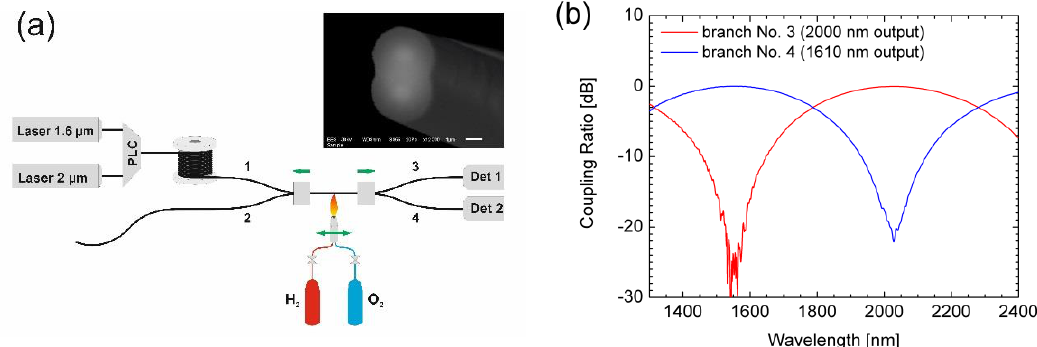
Figure 5. ( a ) Setup of the tapering rig for producing fiber components by the fused-biconically-tapered fabrication method. PLC: Planar lightwave circuit; Det: detector. Inset: scanning-electron-microscope image of the cross section near the waist position of the tapered region (the waist width and height as orientated in the shown inset were 3.7 µ m and 5.5 µ m, respectively); ( b ) Spectral transmission of the wavelength division multiplexers (WDMs) for combination of the pump and the signal in Tm fiber